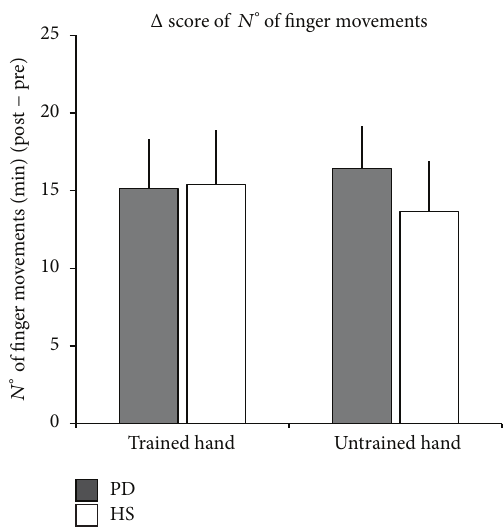
Figure3:Behaviouraldata,showing Δ scoreofthenumbersoffingermovementsperformedinoneminute(numberoffingermovements/min after MVF training − number of finger movements/min before MVF training) in the trained and untrained hands of both Parkinson’s disease (PD) patients (grey bars) and healthy subjects (HS) groups (white bars). Vertical bars indicate standard error of the mean (SEM).